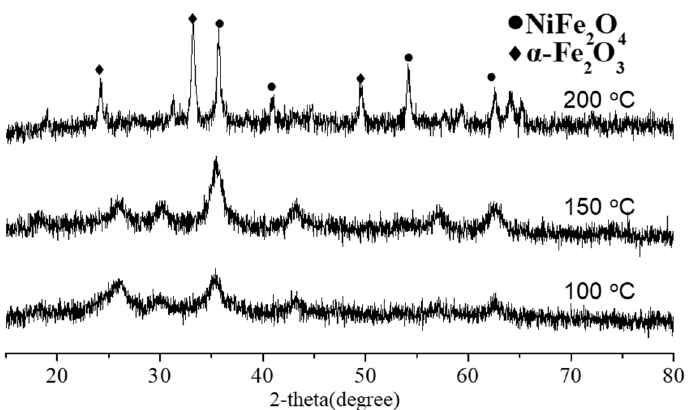
Figure 1. XRD patterns of samples synthesized at different temperature with a reaction time of 2 h. Characteristic peaks for α -Fe 2 O 3 and NiFe 2 O 4 are labeled by filled diamond and filled circle, re- spectively.